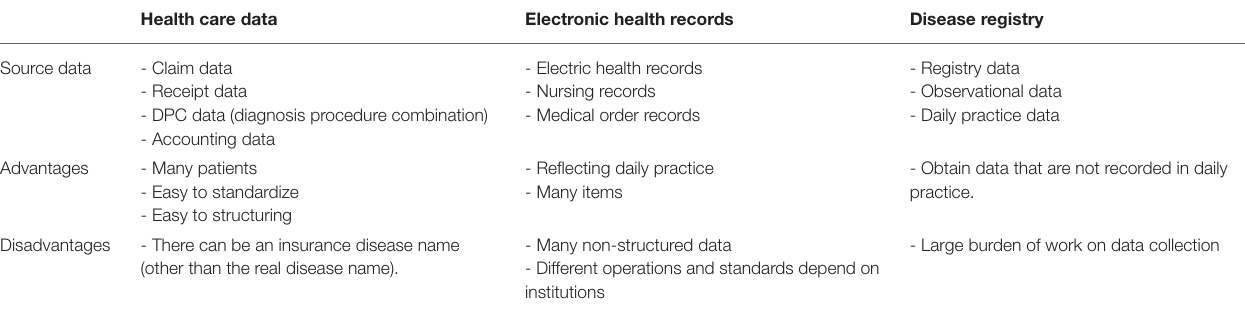
TABLE 2 | Types of real world data and pros/cons for utilization by medical